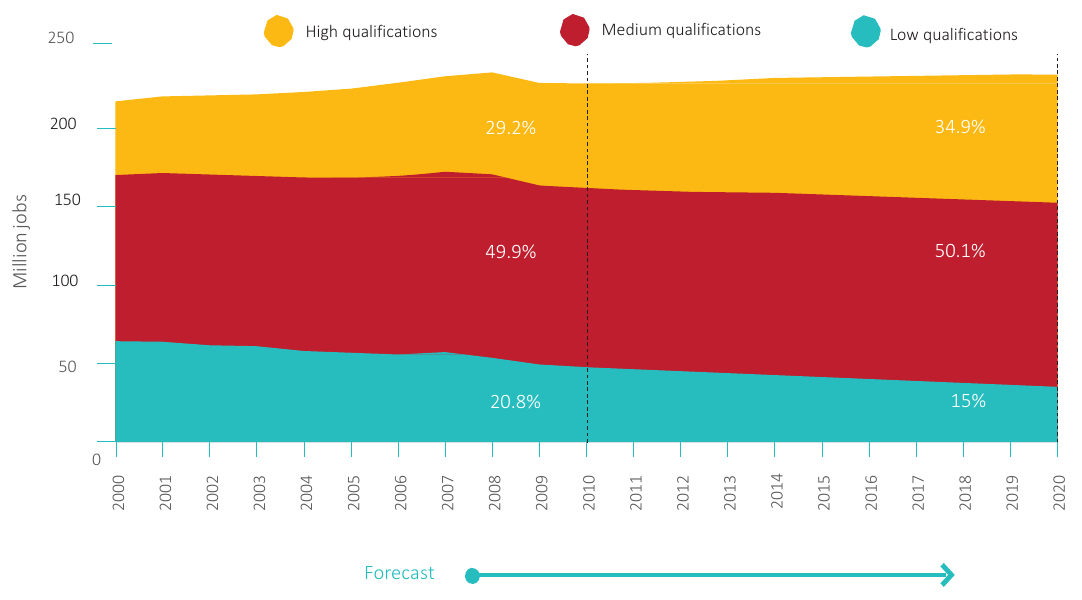
Figure 12. Employment trends by level of qualification, 2000–2020